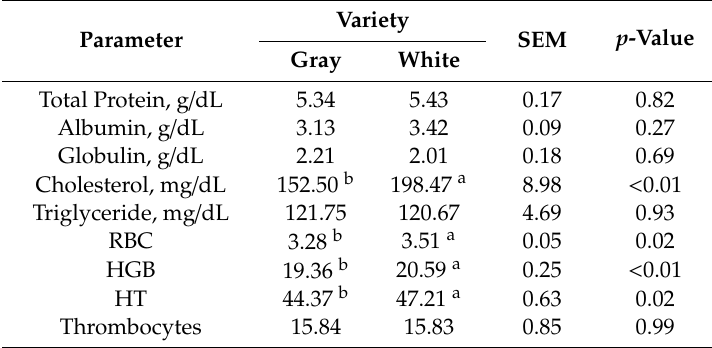
Table 3. Biochemical and hematological blood parameters of two varieties of Japanese quails. Parameter